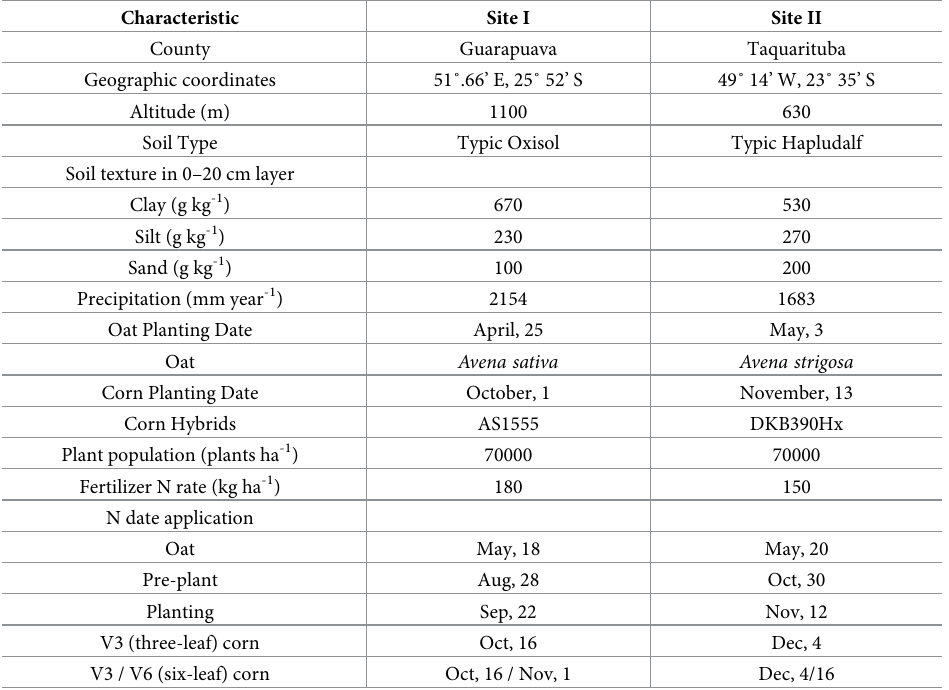
Table 1. Description of sites and management practices